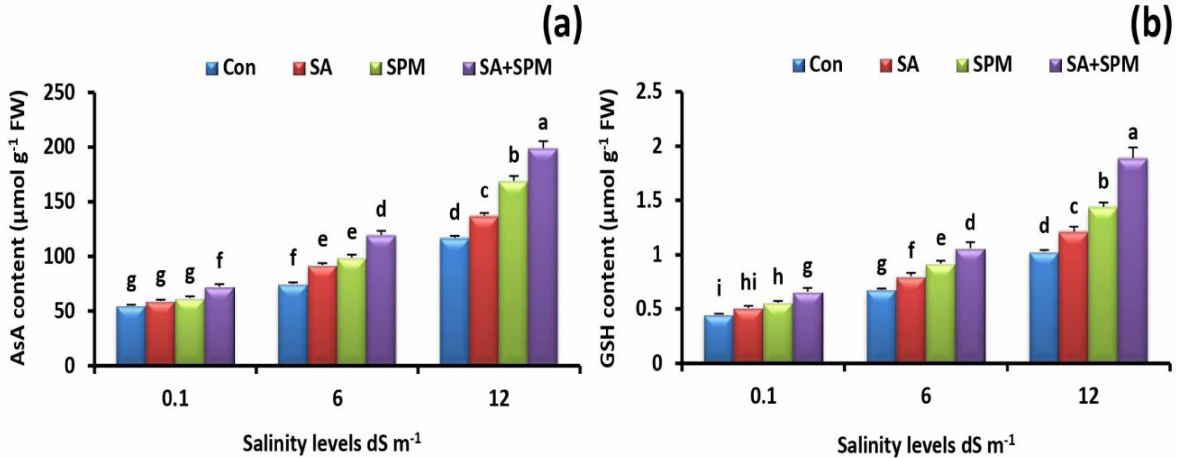
Figure 7. Effect of salicylic acid (SA) and/or spermine (SPM) foliage applications on the content of ( a ) ascorbate (AsA) and ( b ) reduced glutathione (GSH) in leaves of wheat plants exposed to non-saline and saline (6.0 and 12.0 dS m − 1 ) conditions. The results showed the mean ± SE of four replicates. Different letters indicate significant differences at ( p < 0.05) level according to Duncan’s